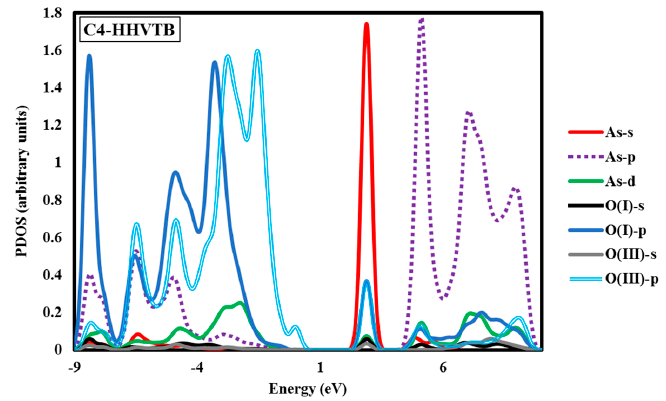
Figure 5. Projected density of states for the adsorption of arsenate on the (012) surface of Al 2 O 3 . Finally, we discuss the results of the cluster models. One BB As(V) configuration and three BM As(V) configurations for the Al clusters are modelled, and the optimized geometries are shown in Figure 6. Inspection of the As–O bond distances in Table 2 shows that for the cluster model, the distances are generally longer than for the slab model. In both the small cluster model and the periodic slab model, the Al–O surf distance for the adsorbate-free species is shorter than that of arsenate-adsorbed one. The Al–O cluster axial separation is 1.816 Å for the freestanding cluster, whereas the same distance for the As-adsorbed complex is 1.882 Å. The Al–O(I) distance for the A3 bare surface is 1.815 Å. The same distance for the A3-HHBB configuration is 1.867 Å and 1.827 Å for the